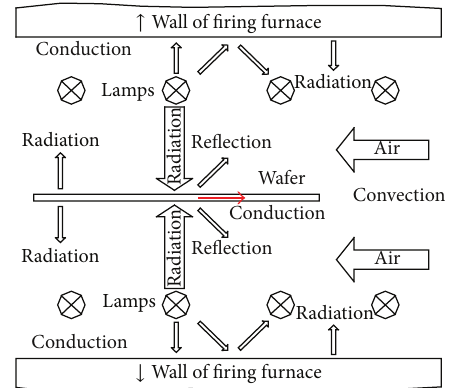
Figure 1: Heat transfer mechanism.